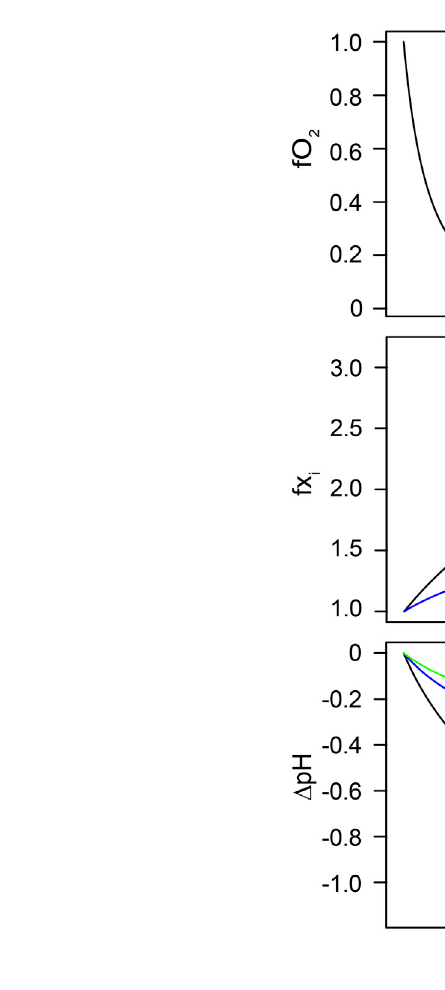
FIGURE 5 Model outputs of derived Ce oxidation models in Table 2. We use fCe/Ce* to describe the magnitude/ratio of increase in Ce anomaly. The magnitude of change in dissolved oxygen level, carbonate and phosphate ions are expressed as fO 2 and f X i , respectively. The pH change is expressed as Δ pH, meaning the pH of increased Ce anomaly subtracting the starting